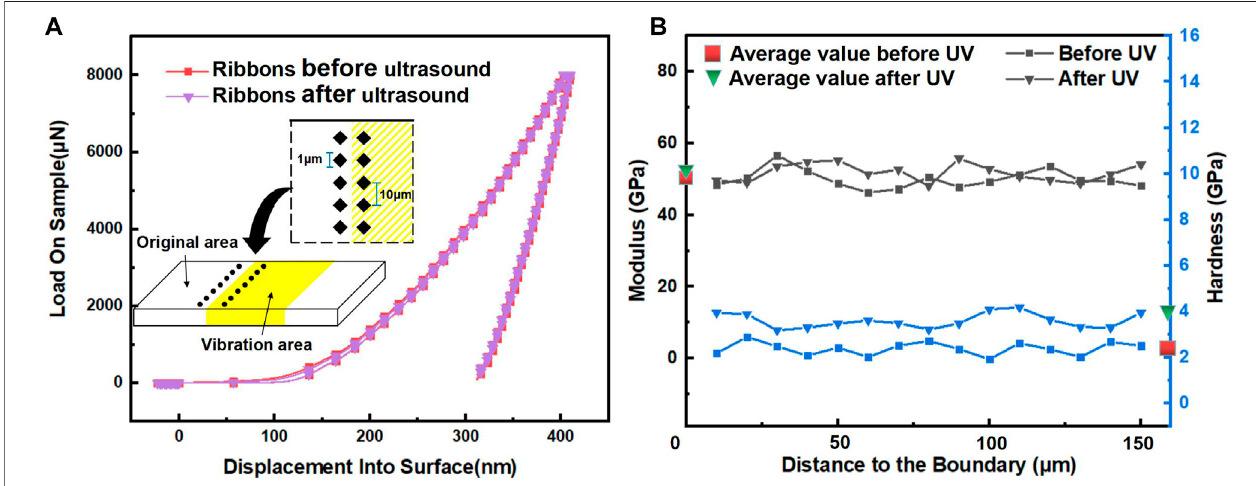
FIGURE 3 | (A) Load-depth curves of the ribbons, the inset shows the nanoindentation dotting method. (B) Changes in the hardness and elastic modulus of the ribbon with surface displacement.